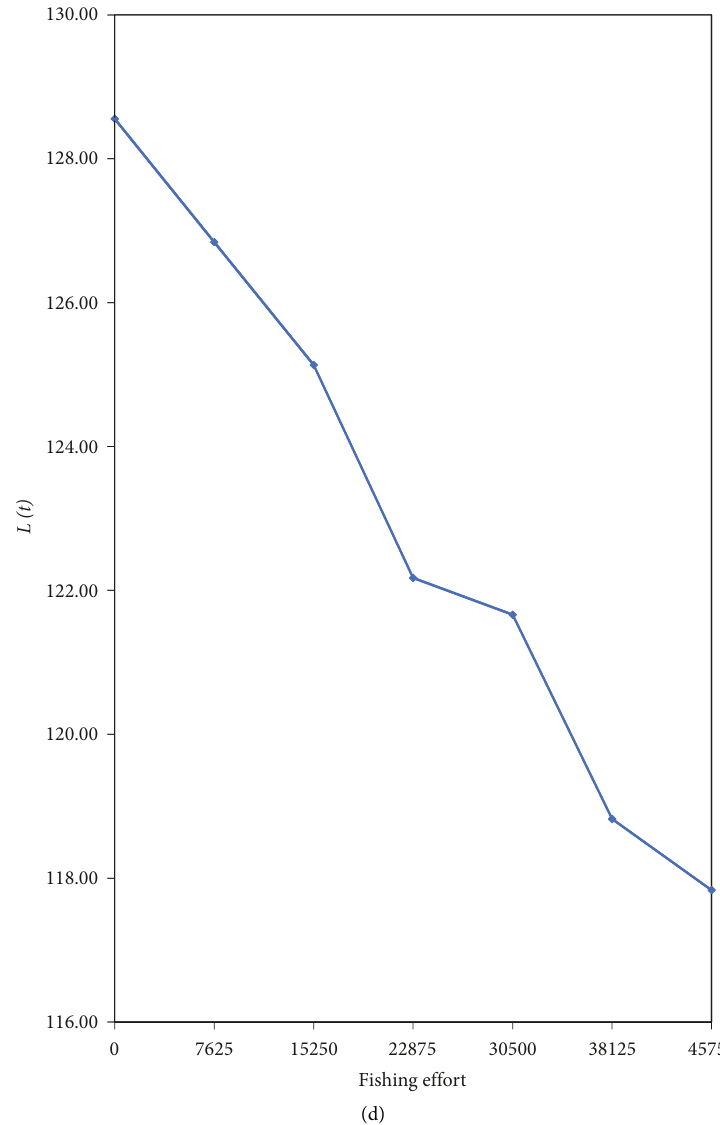
Figure 11: (a) Time series of Limnothrissa miodon for varying a for model system (2); (b) 12-month average plot of Limnothrissa miodon for varying a ; (c) time series of Limnothrissa miodon for varying fishing effort for model system (2) with E � 0, E � 22875, and E � 38125; (d) 12-month average plot of Limnothrissa miodon to fishing effort and with assumed initial condition: N ( 0 ) � 10 ,P ( 0 ) � 7 ,Z ( 0 ) � 4 ,L ( 0 ) � 2 using the default parameter